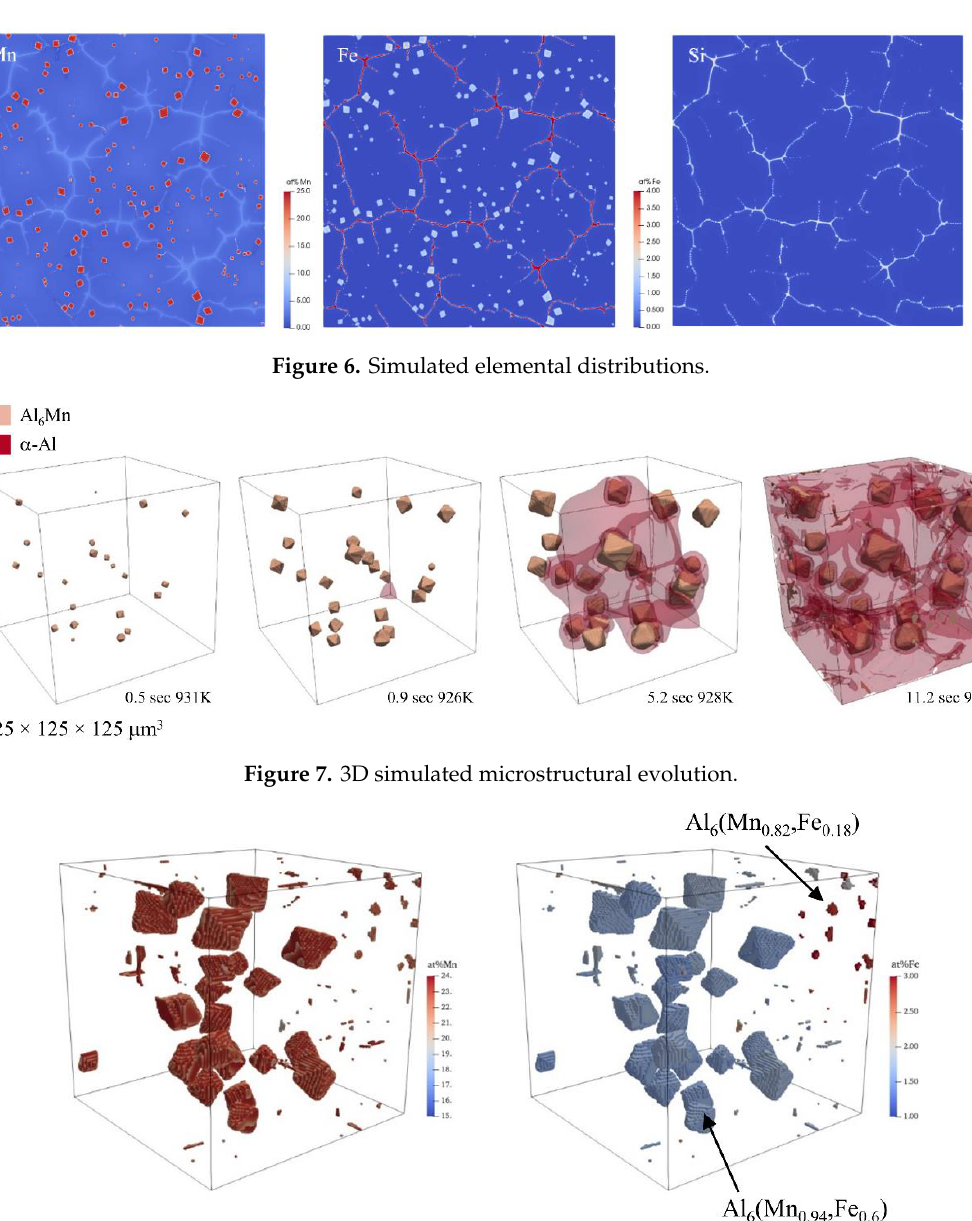
Figure 8. Mn and Fe distributions in the precipitates when the solidification was completed.